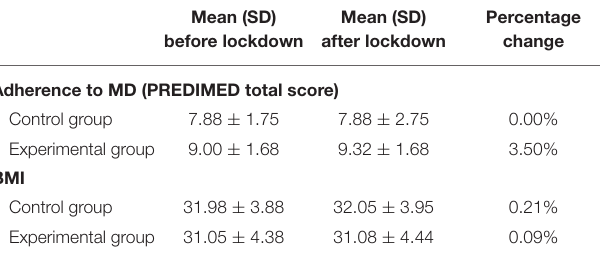
TABLE 3 | Mean of percentage change by groups in the score of Adherence to the MD and nutritional status before and after the